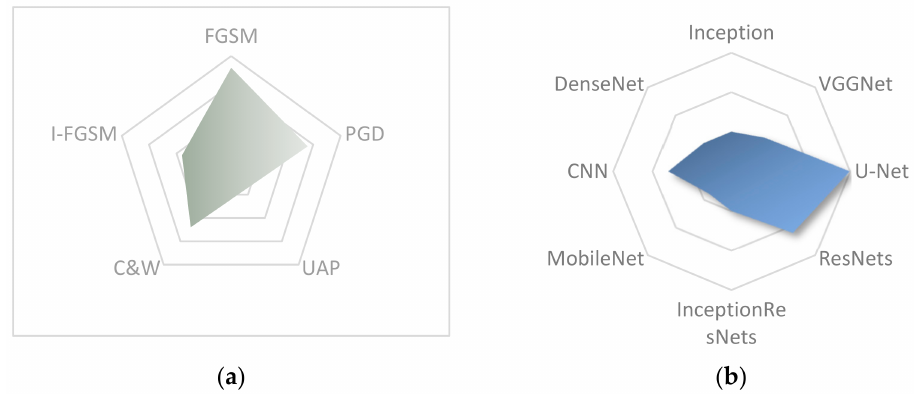
Figure 6. Most often used attacks ( a ) and models ( b ) in adversarial medical